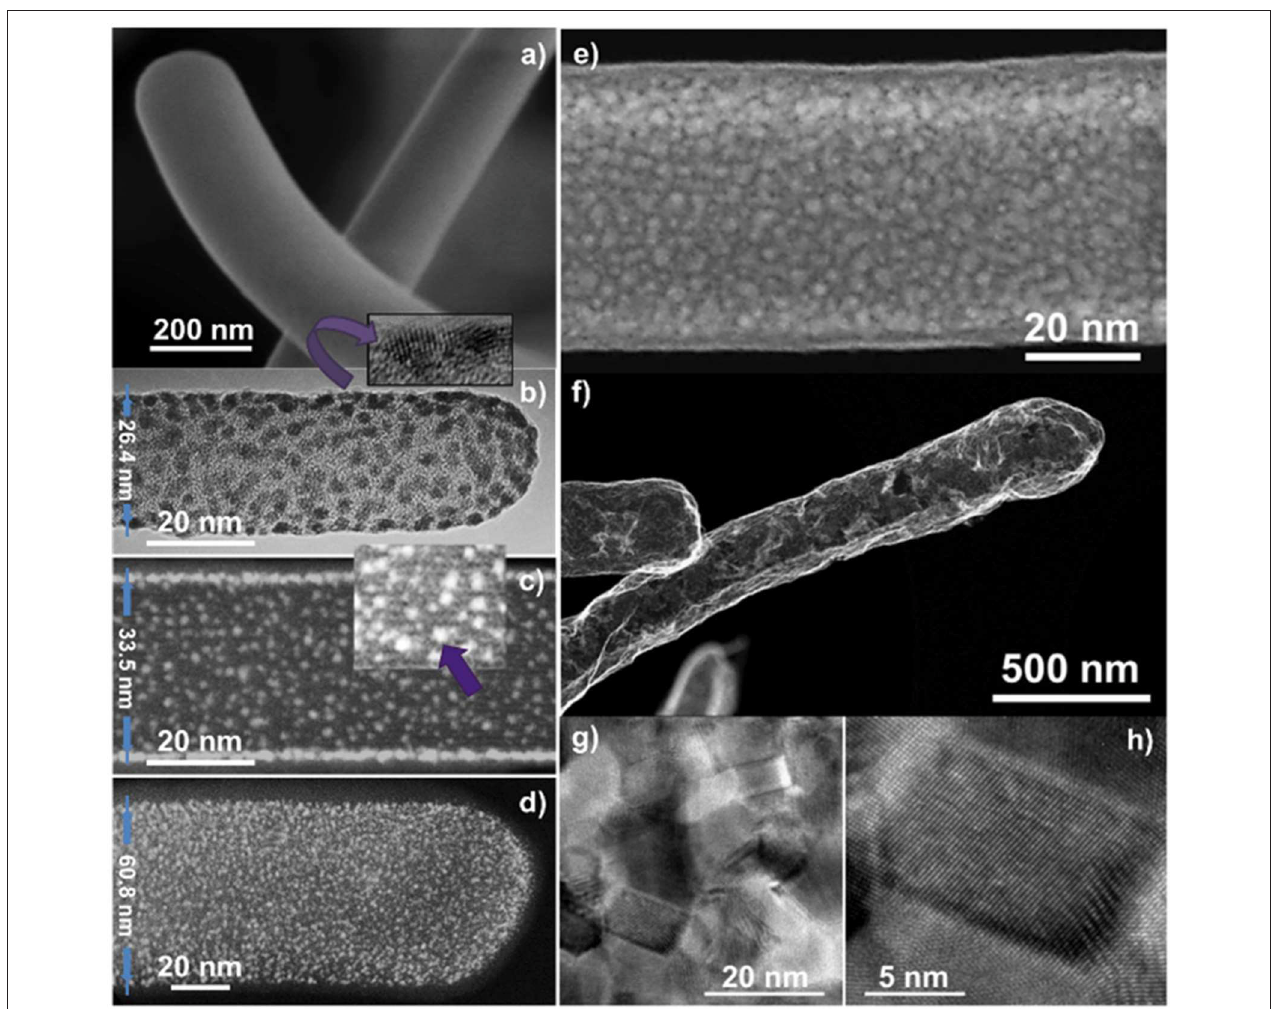
FIGURE 9 | SEM (a,f) , TEM (b) , HAADF-STEM (c–e) , and High-Resolution TEM (inset in b and g,h ) micrographs of PtOEP RPAVD-Ar shells on H 2 Pc nanowires (a) under different soft-plasma etching and annealing